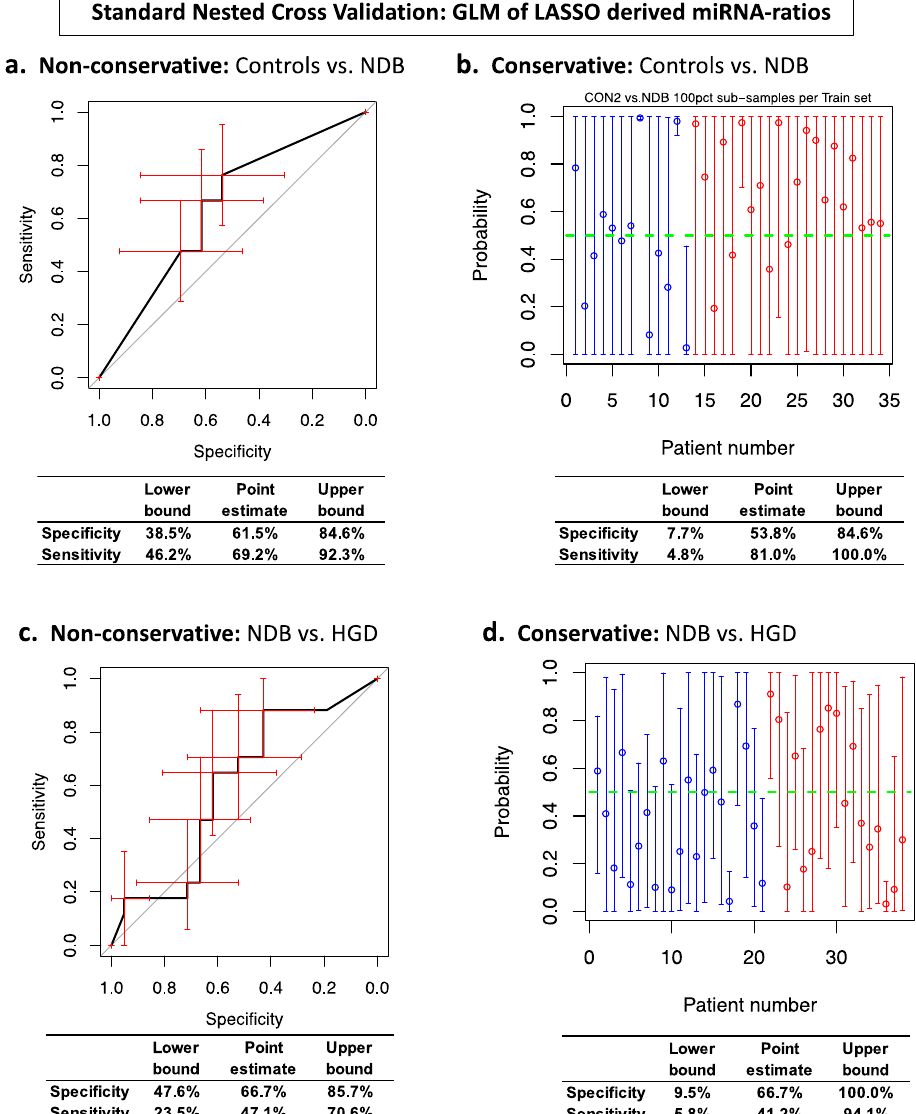
Figure 1. Standard Nested Cross Validation ROC curves and prediction probability plots for generalised linear regression (GLM) biomarker models. Panels ( a , c ): ROC curve error bars (red) are non-conservative bootstrapped 95% confidence intervals. Panels ( b , d ): Prediction probability plot circles are average prediction probabilities per sample. Prediction probability error bars are the conservative 95% confidence intervals for each sample. Top right, panel ( b ): blue circles are Control samples and red circles are NDB samples. Bottom right, panel ( d ): blue circles are NDB samples and red circles are HGD samples.